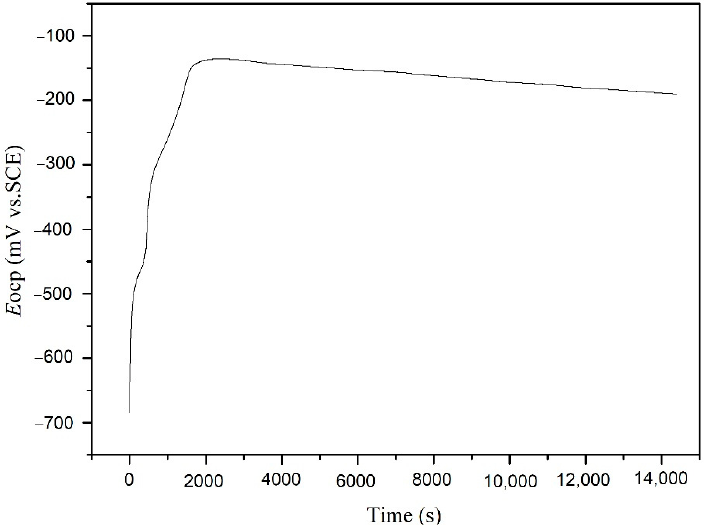
Figure 11. Open circuit potential of the carbon steel electrode immersed in NSCS for 21 days after depolarization.